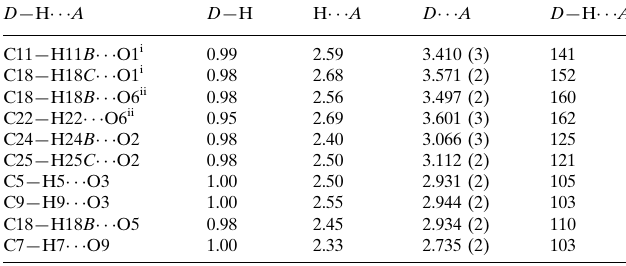
Hydrogen-bond geometry (A˚ , (cid:2) ). D —H (cid:4)(cid:4)(cid:4)